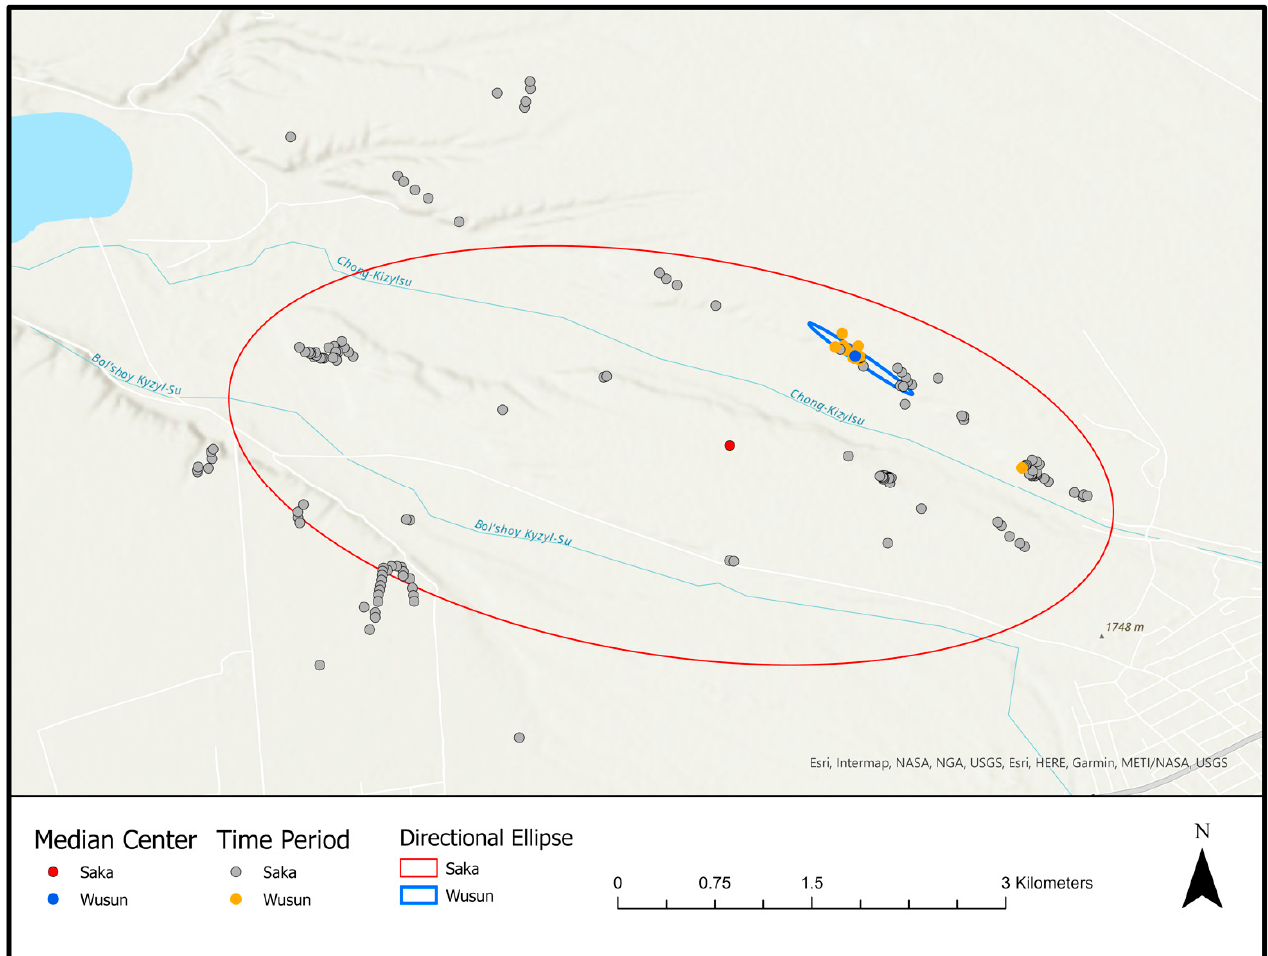
Figure 11. In this map, Wusun kurgans are noted by the orange symbology, while the Saka Kurgans are noted by the grey symbology. Both exhibit a similar directional ellipse, that falls in line with the topography of the area (e.g., following ridgelines), however the red (Saka) and blue (Wusun) exhibit two distinct median centers of spatial distribution.